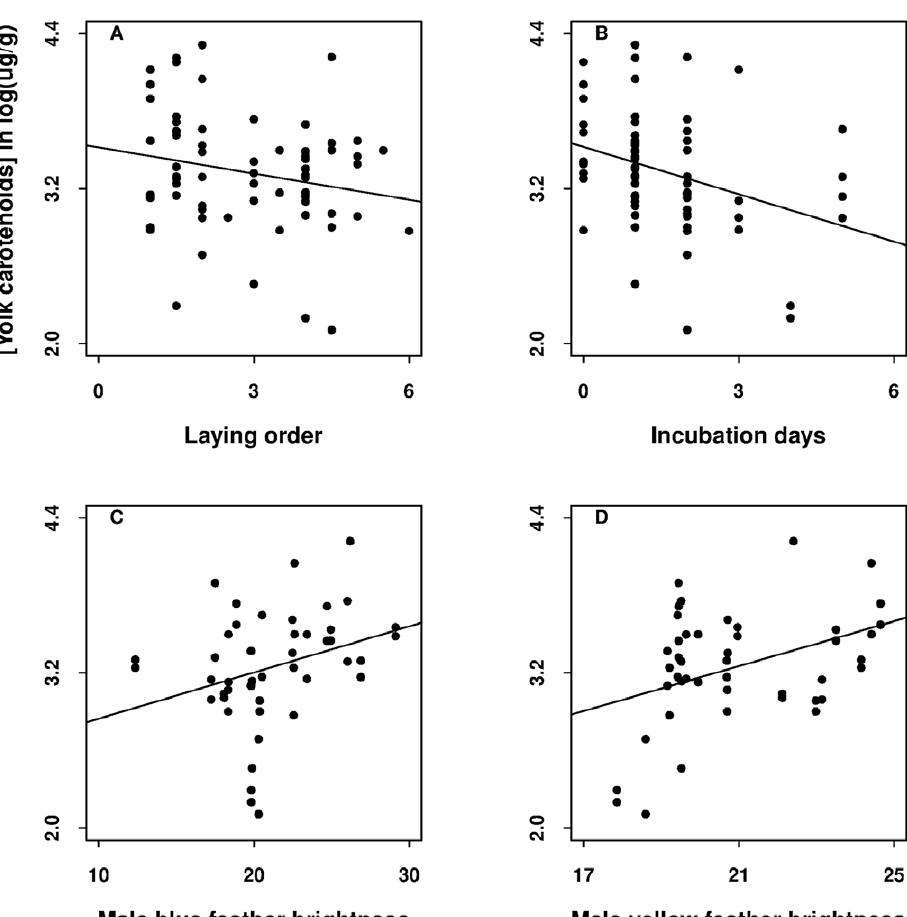
Figure 4. The significant predictors of yolk carotenoid concentration in log( m g.g 2 1 ) in blue tit eggs. They were (A) laying order, (B) number of days of clutch incubation, (C) blue feather brightness, and (D) yellow feather brightness of males. Plots a–b show the data used in the egg- and female-trait model, c-d in the male-trait model (Table 3). doi:10.1371/journal.pone.0050389.g004 PLOS ONE |